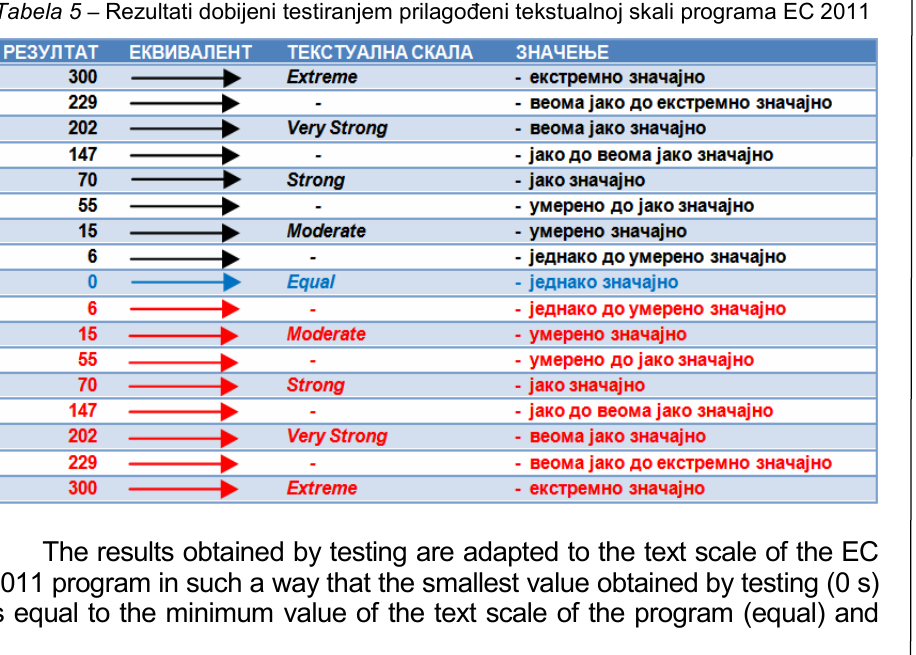
Table 5 – Results obtained by testing adapted to the text scale of the EC 2011 program Таблица 5 – Результаты , полученные путем тестирования , приспособленные пользовательской шкале программы ЕС